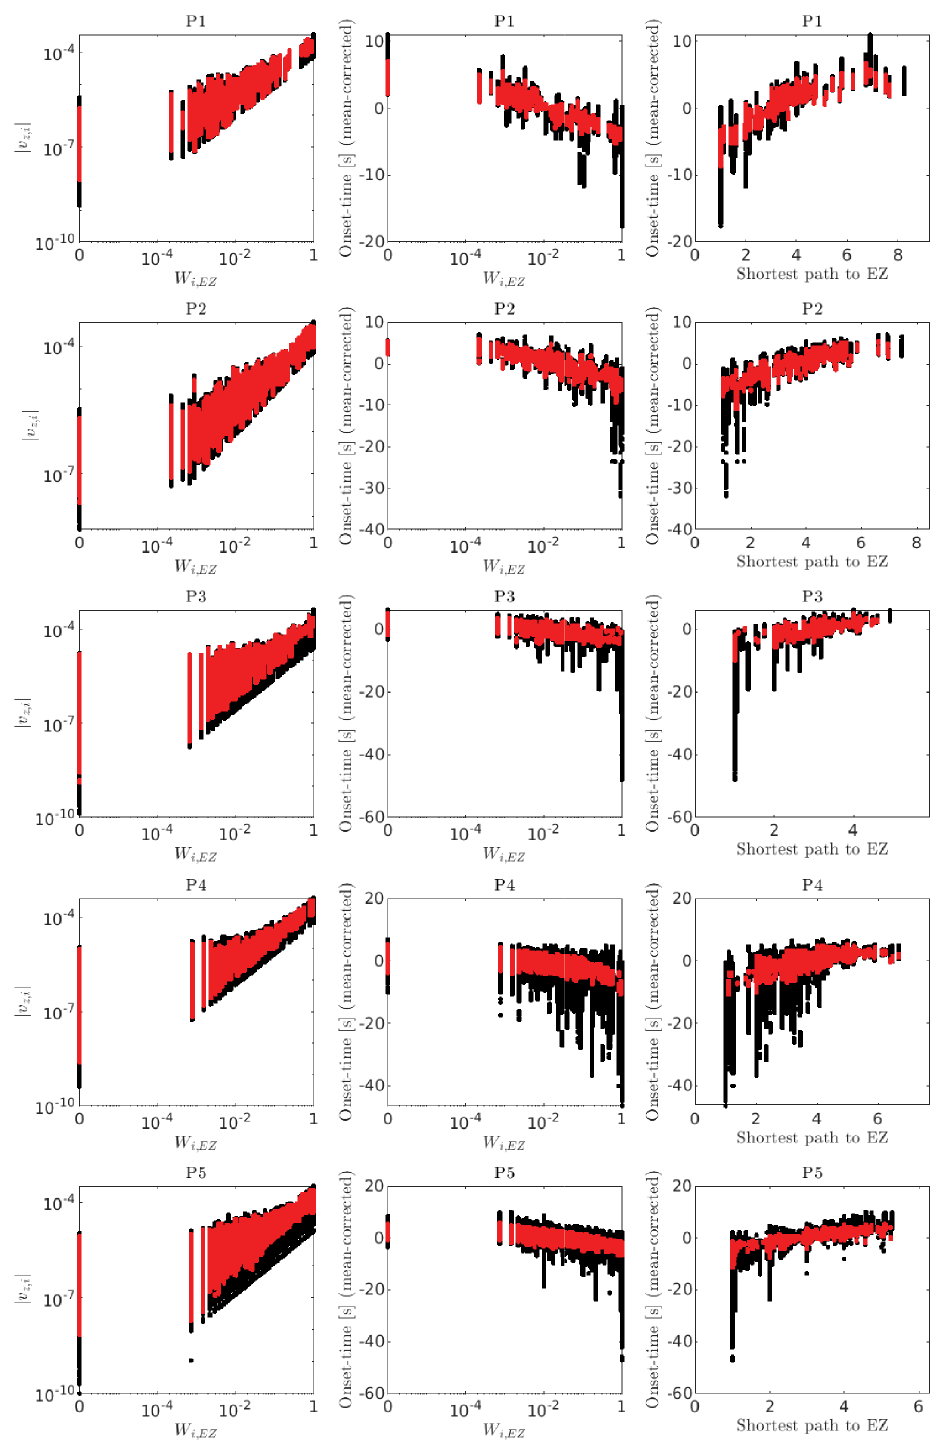
Fig 7. Relationships among magnitudes of leading eigenvector components, patient-specific connectivity matrices, seizure onset times and path lengths: Statistical summary. Same conventions as in Fig 6. Each row corresponds to a different patient-specific connectivity (P1, P2 and so on, from top to bottom). As in Fig 5, each dot corresponds to a network with a particular active EZ node, global connectivity strength and surrounding node excitability { w , x 0 } parameter set, noise level and stochastic realization. Three noise levels were examined ( σ = 0.05, σ = 0.1, and σ = 0.15). The range of ( w , x 0 ) values were set such that seizures spread to the full network (e.g. yellow region